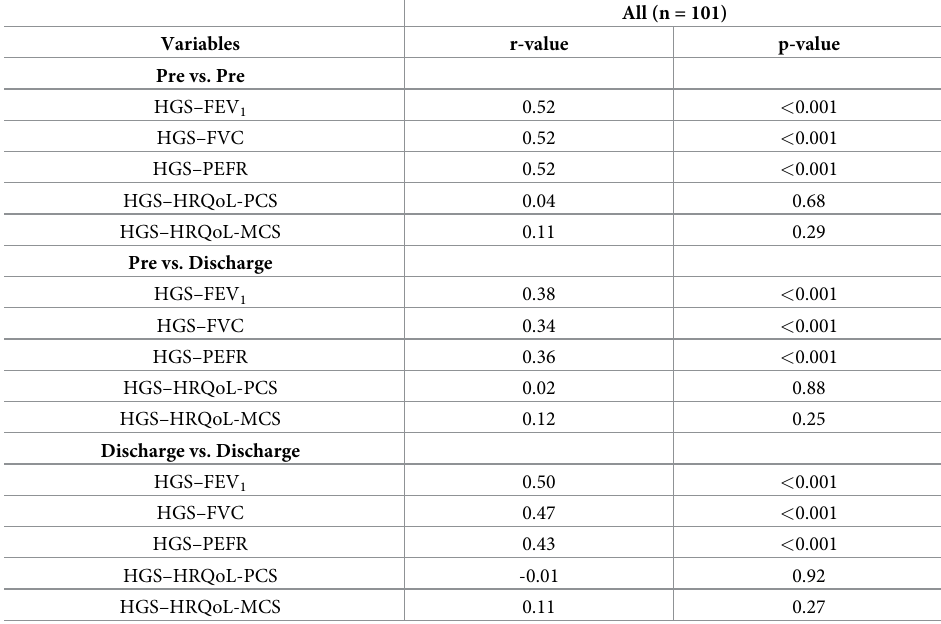
correlations were identified between HGS, and FEV , and FVC and PEFR at the time of phys- 1 iotherapy discharge (Table 3). However, no significant relationships were identified between HGS and HRQoL components, pre-operatively and at physiotherapy discharge (Table 3). Prediction of lung function and health-related quality of life Pre-operatively, height and HGS were the most significant predictors of lung function with height contributing 28–35% and HGS contributing 26–38% of the variance in FEV , FVC and 1 PEFR (Table 4). Other variables such as sex and comorbidities contributed significantly to the Table 3. Relationships between handgrip strength, and lung function and health-related quality of